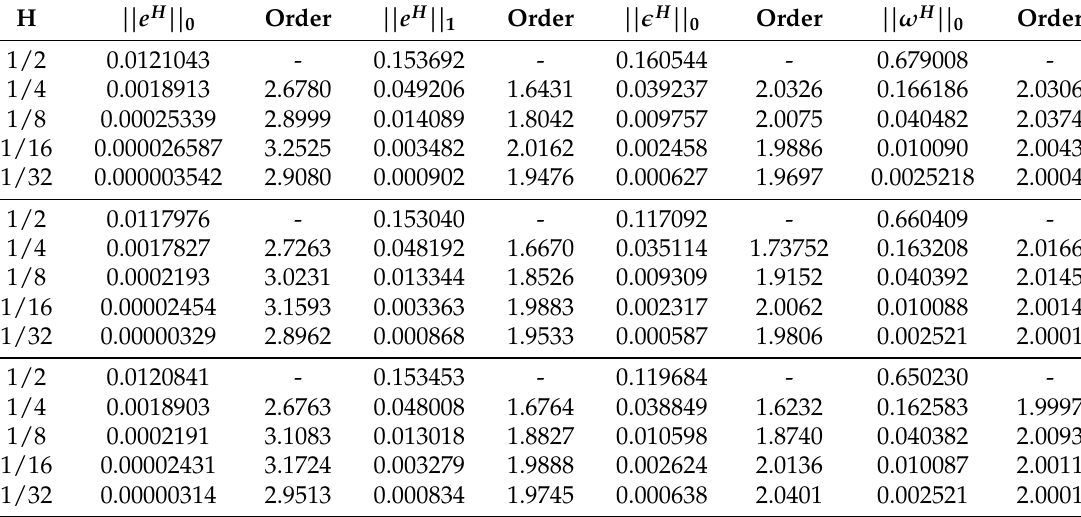
Table 1. One-level method for Oseen viscoelastic fluid flow for different λ = 5.0,1.0,and 0.1 with P 2 − P 1 − P 1 dc finite elements.